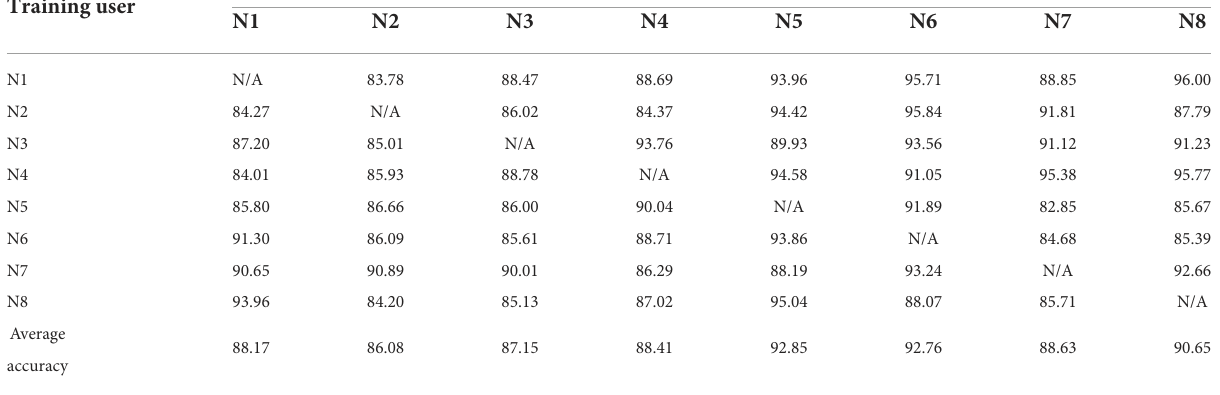
TABLE 1 Experimental results for user-independent CCA-OT framework.